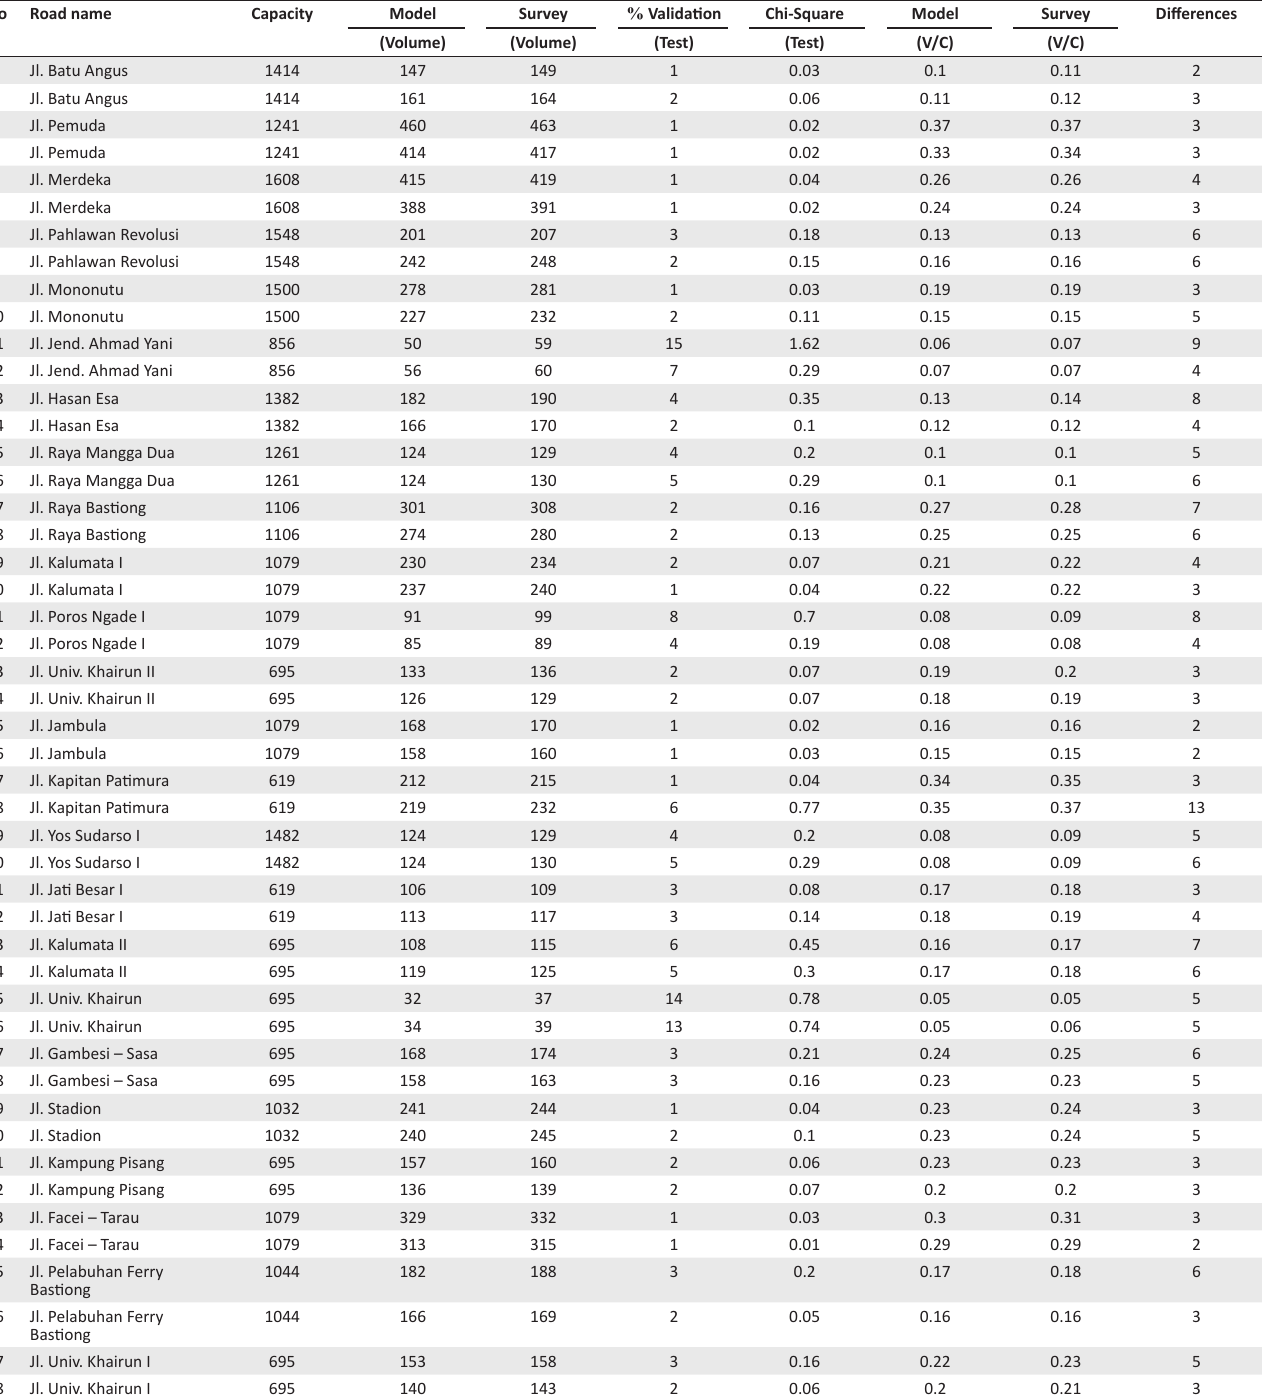
TABLE 1 : Validation of Ternate city road network model in 2020. No Road